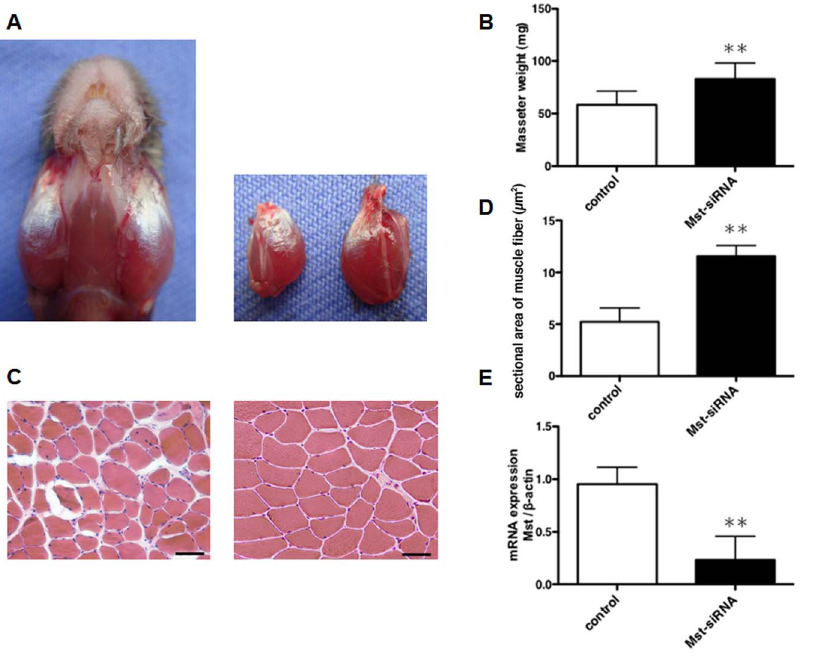
Figure 1. Local administration of Mst-siRNA/ATCOL complex causes an enlargement of the masseter muscle in the mCAV-3Tg mouse. (A) Photographs of siRNA-treated muscles. The left muscle injected with the Mst-siRNA/ATCOL complex show a marked increase in muscle mass compared to the right muscle injected with the control siRNA. (B) Average muscle weights. The muscle weight of the Mst-siRNA-treated masseter muscle is significantly larger than that of the control muscle. (C) Hematoxylin and eosin staining of the control and Mst-siRNA-treated masseter muscles. Scale bars=50 m m. (D) Average cross-sectional areas. The sectional area of fiber is significantly larger in the Mst-siRNA-treated masseter muscle than in the control. (E) The ratio of the amount of myostatin mRNA for the masseter muscles. The mRNA expression level in the Mst- siRNA-treated masseter muscle is significantly higher than that in the control masseter muscle. Graphed data are expressed as mean 6 SD. ** p , 0.01, n=12.